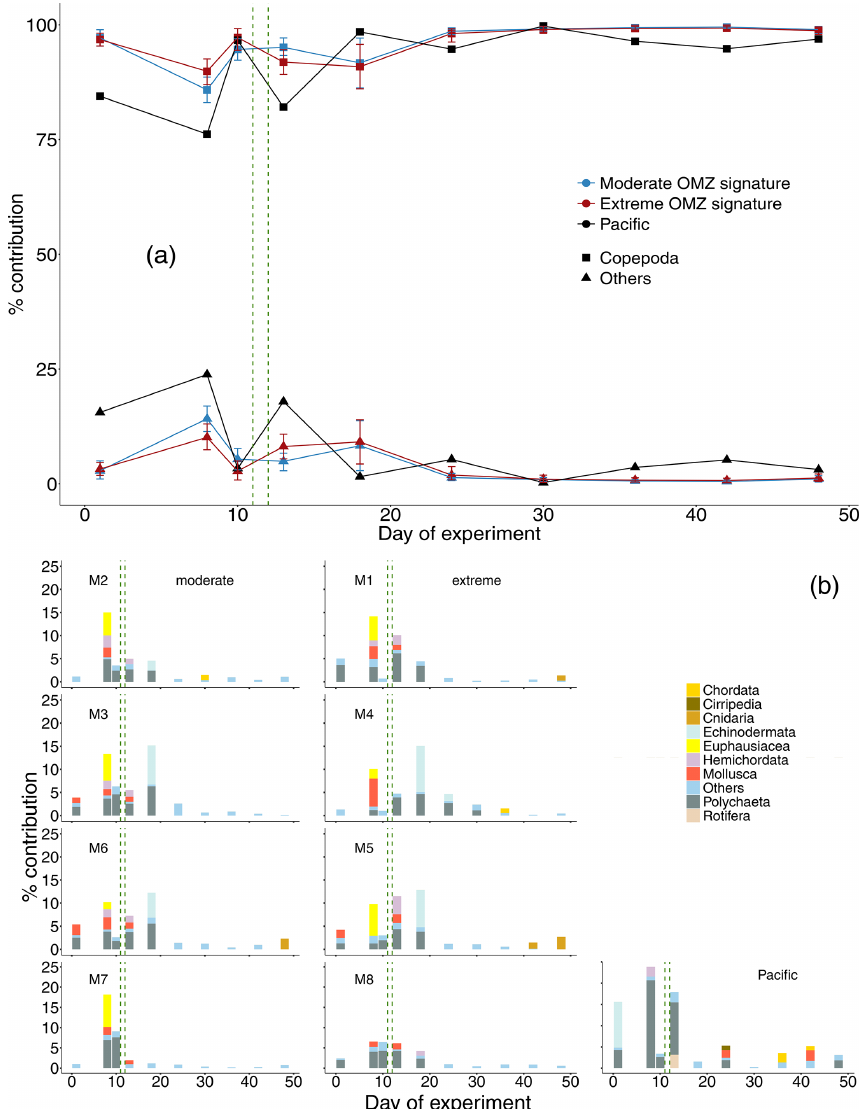
Figure 4. (a) Percent contribution of major taxonomic groups to total mesozooplankton abundance: Copepoda and “others” (Chordata, Cirri- pedia, Cnidaria, Echinodermata, Euphausiacea, Hemichordata, Mollusca, Polychaeta, Rotifera). Shown is the mean across OMZ treatments (moderate and extreme signature mesocosms, respectively) with 95% confidence intervals and the contribution of copepods and “others” in the Pacific. (b) The percent contribution of the category “others” as shown in (a) split into taxonomic groups. The category “others” summarizes all taxonomic groups that contributed less than 1% on a particular sampling day. The green vertical dashed lines indicate the days of OMZ water